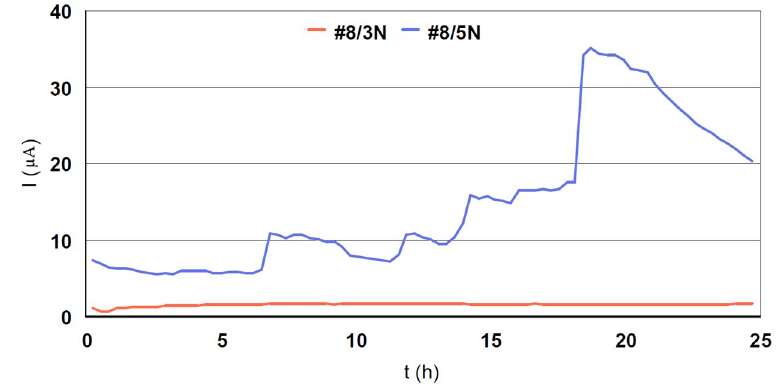
Figure 12. Galvanic currents measured in couplings #8/(3N, 5N)18K gold.